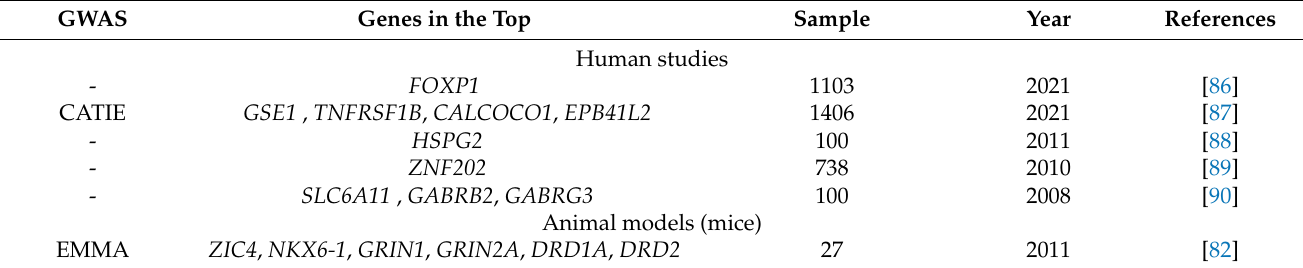
Table 6. GWAS of tardive